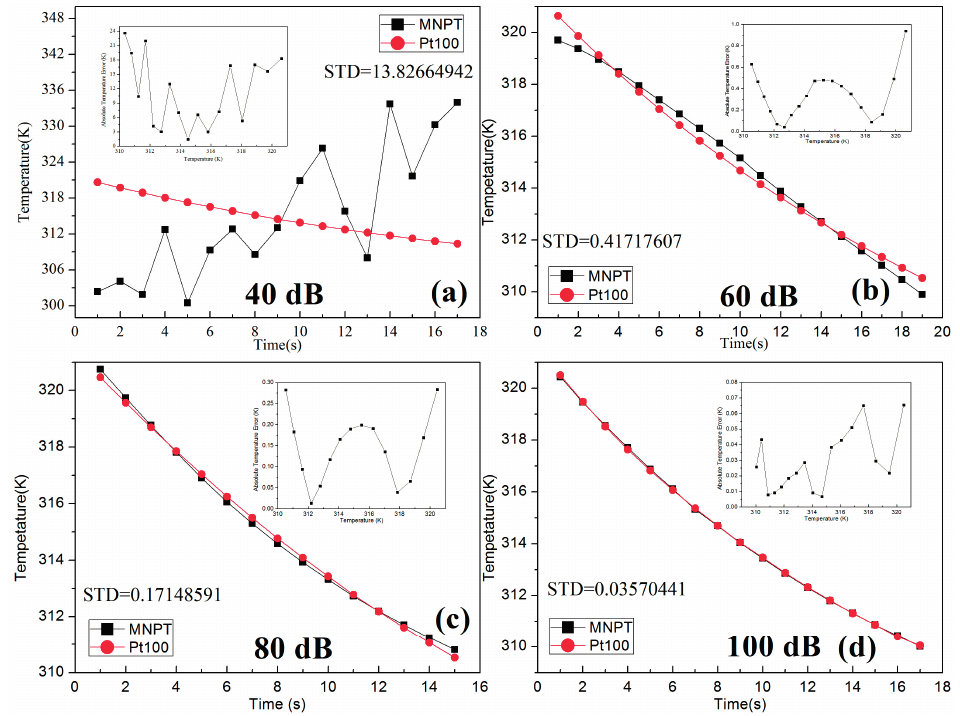
Figure 10. The measurement error of the MNPT resulted from the different signal-to-AC bias ratio. ( a – d ) represent different measurement error with respect to the signal-to-AC bias ratio of 40 dB, 60 dB, 80 dB and 100